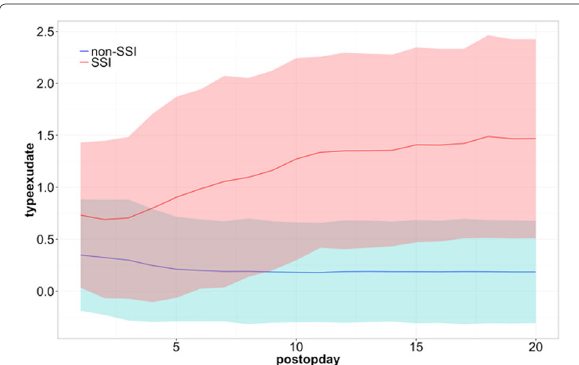
Fig. 3 Example of the longitudinal data of wound assessment that could gradually separate the SSI group with the non-SSI group as the condition progresses over time